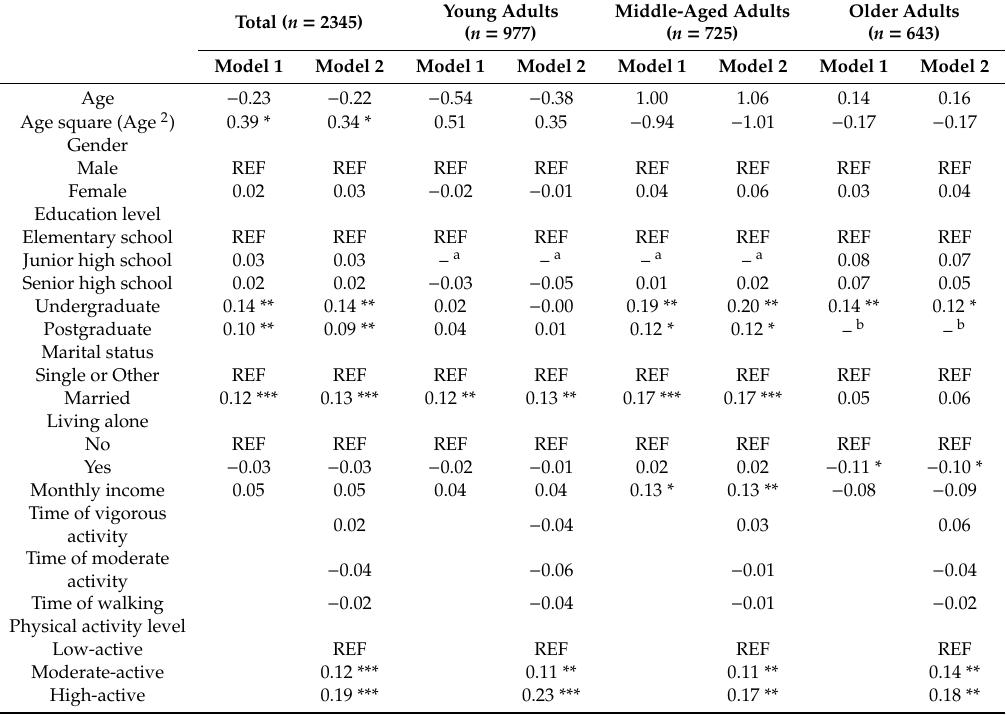
Table 2. Summary of regression analyses: demographic characteristics, physical activity, and life